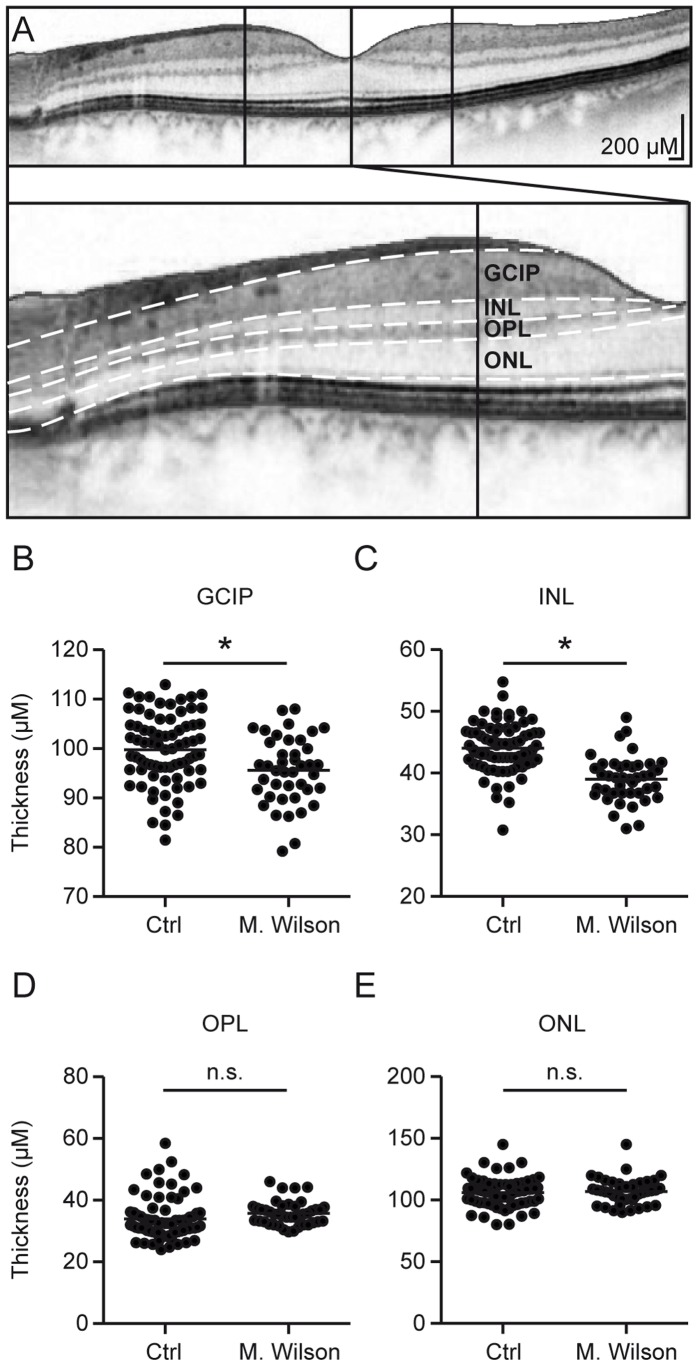
Manual segmentation: the thickness of GCIP and INL is reduced in Wilson’s disease. AThe different retinal layers were manually segmented in single horizontal foveal scans and the images are displayed as negatives to better differentiate the different layers. The thickness of the different layers was measured at the vertical lines indicating the thickest point, both nasally and temporally of the fovea, except for the ONL, which was measured centrally along the vertical line. B–E Scatter plots of the mean thickness of the different retinal layers. Each point represents the mean of the two eyes of one patient. The mean of all patients is indicated by a horizontal bar. Significant differences are indicated by asterisks (p<0.05, two-tailed t test); non-significant differences are indicated as n.s.